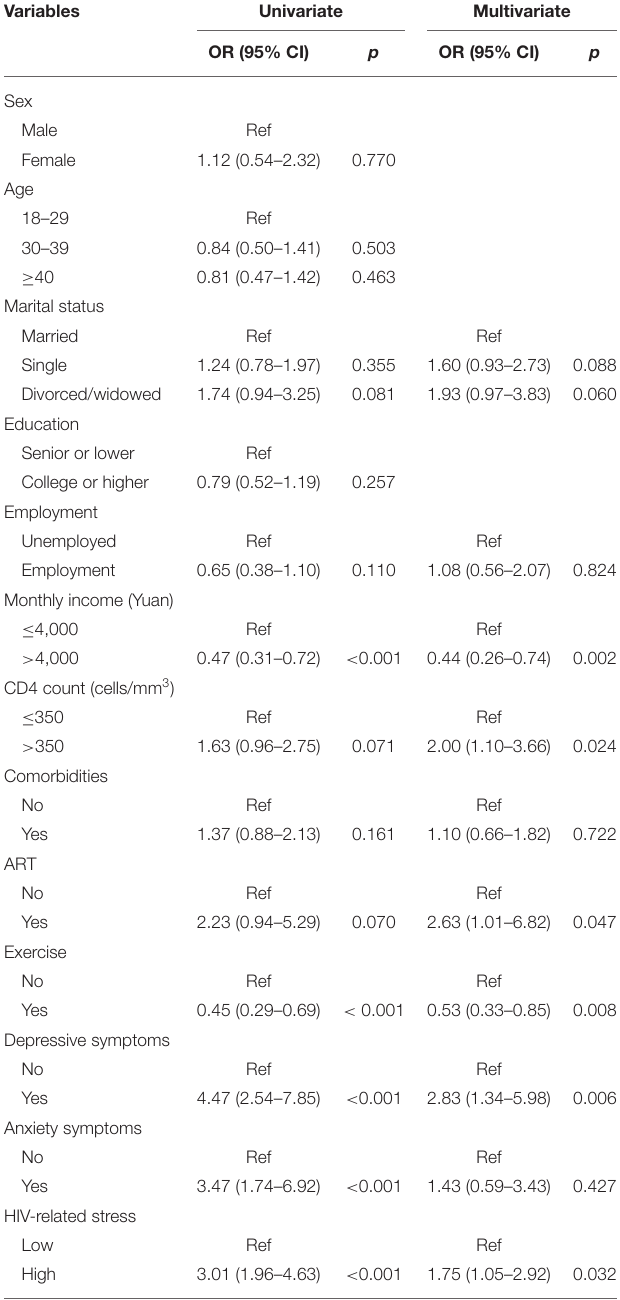
TABLE 5 | Factors associated with sleep quality in